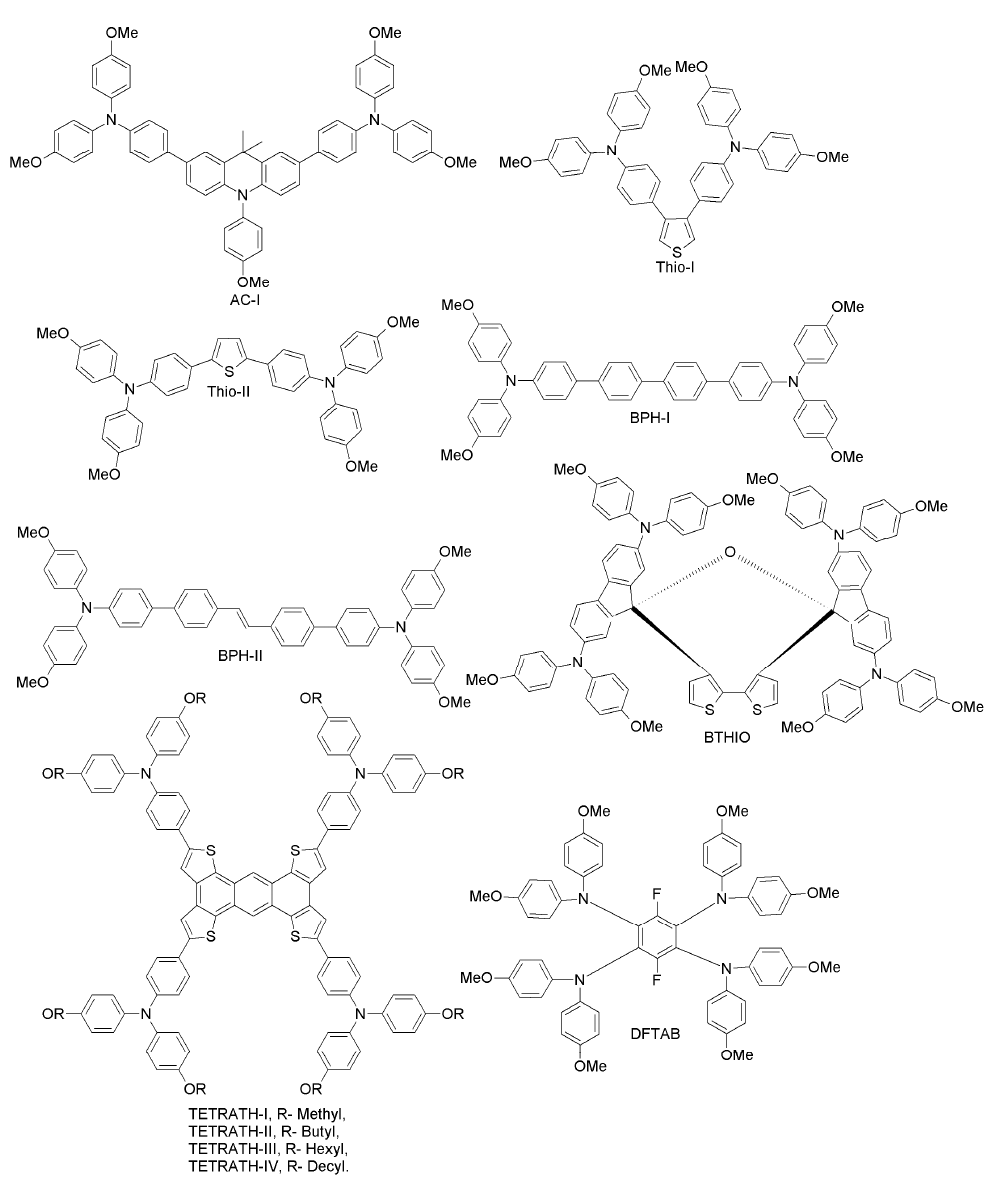
Figure 8. Acridine-, thiophene-, biphenyl-, bithiophene-, tetrathiophene- and phenyl-based HTMs. (e) Triazine-based HTMs